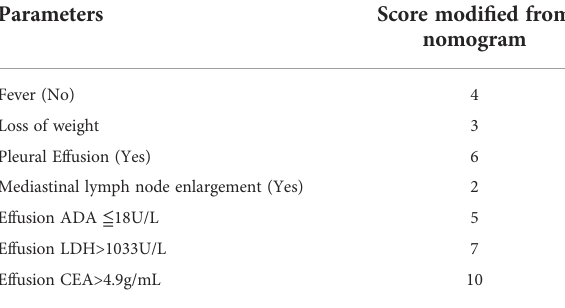
TABLE 3 Scoring system developed from a nomogram of the training